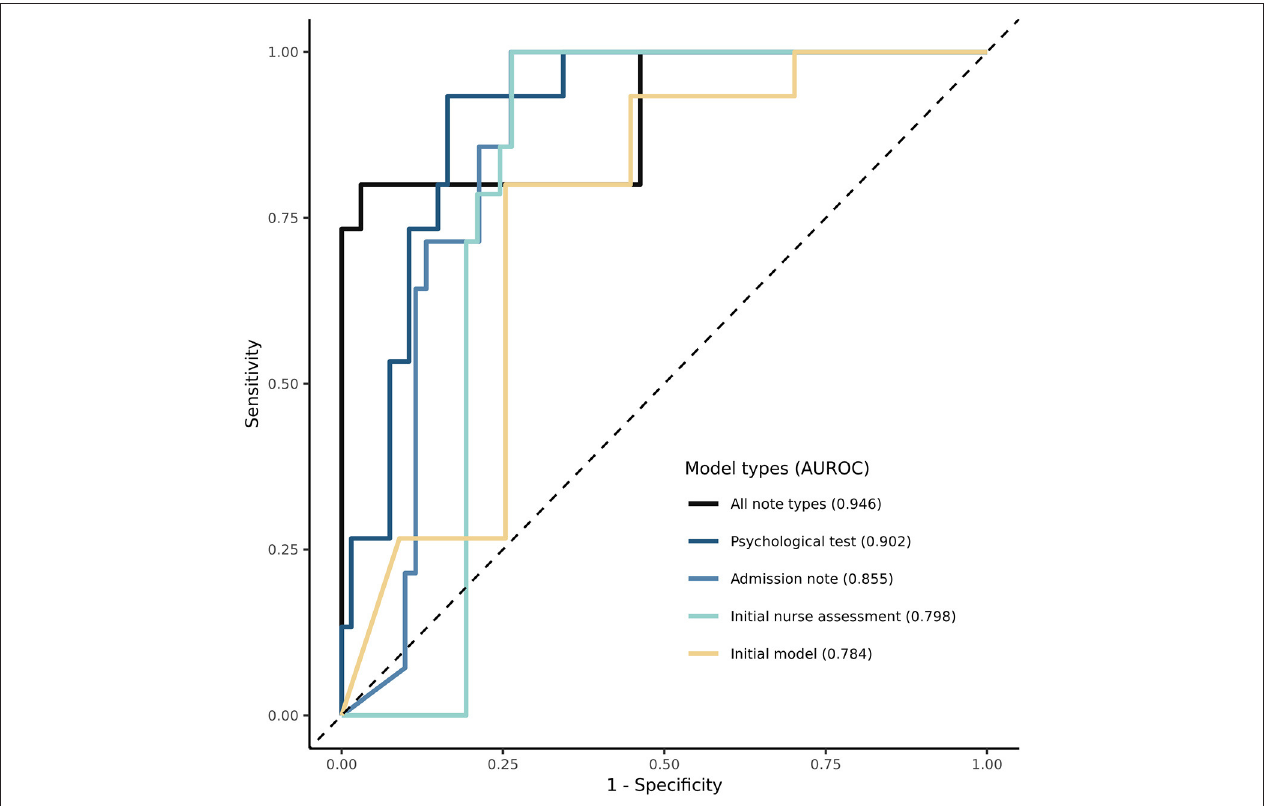
FIGURE 2 | Receiver Operating Characteristic (ROC) curve of models predicting relapse in psychosis. The ROC curve for initial model and NLP-enriched models is shown. Performance of models using area under the receiver operating characteristic curve (AUC) is